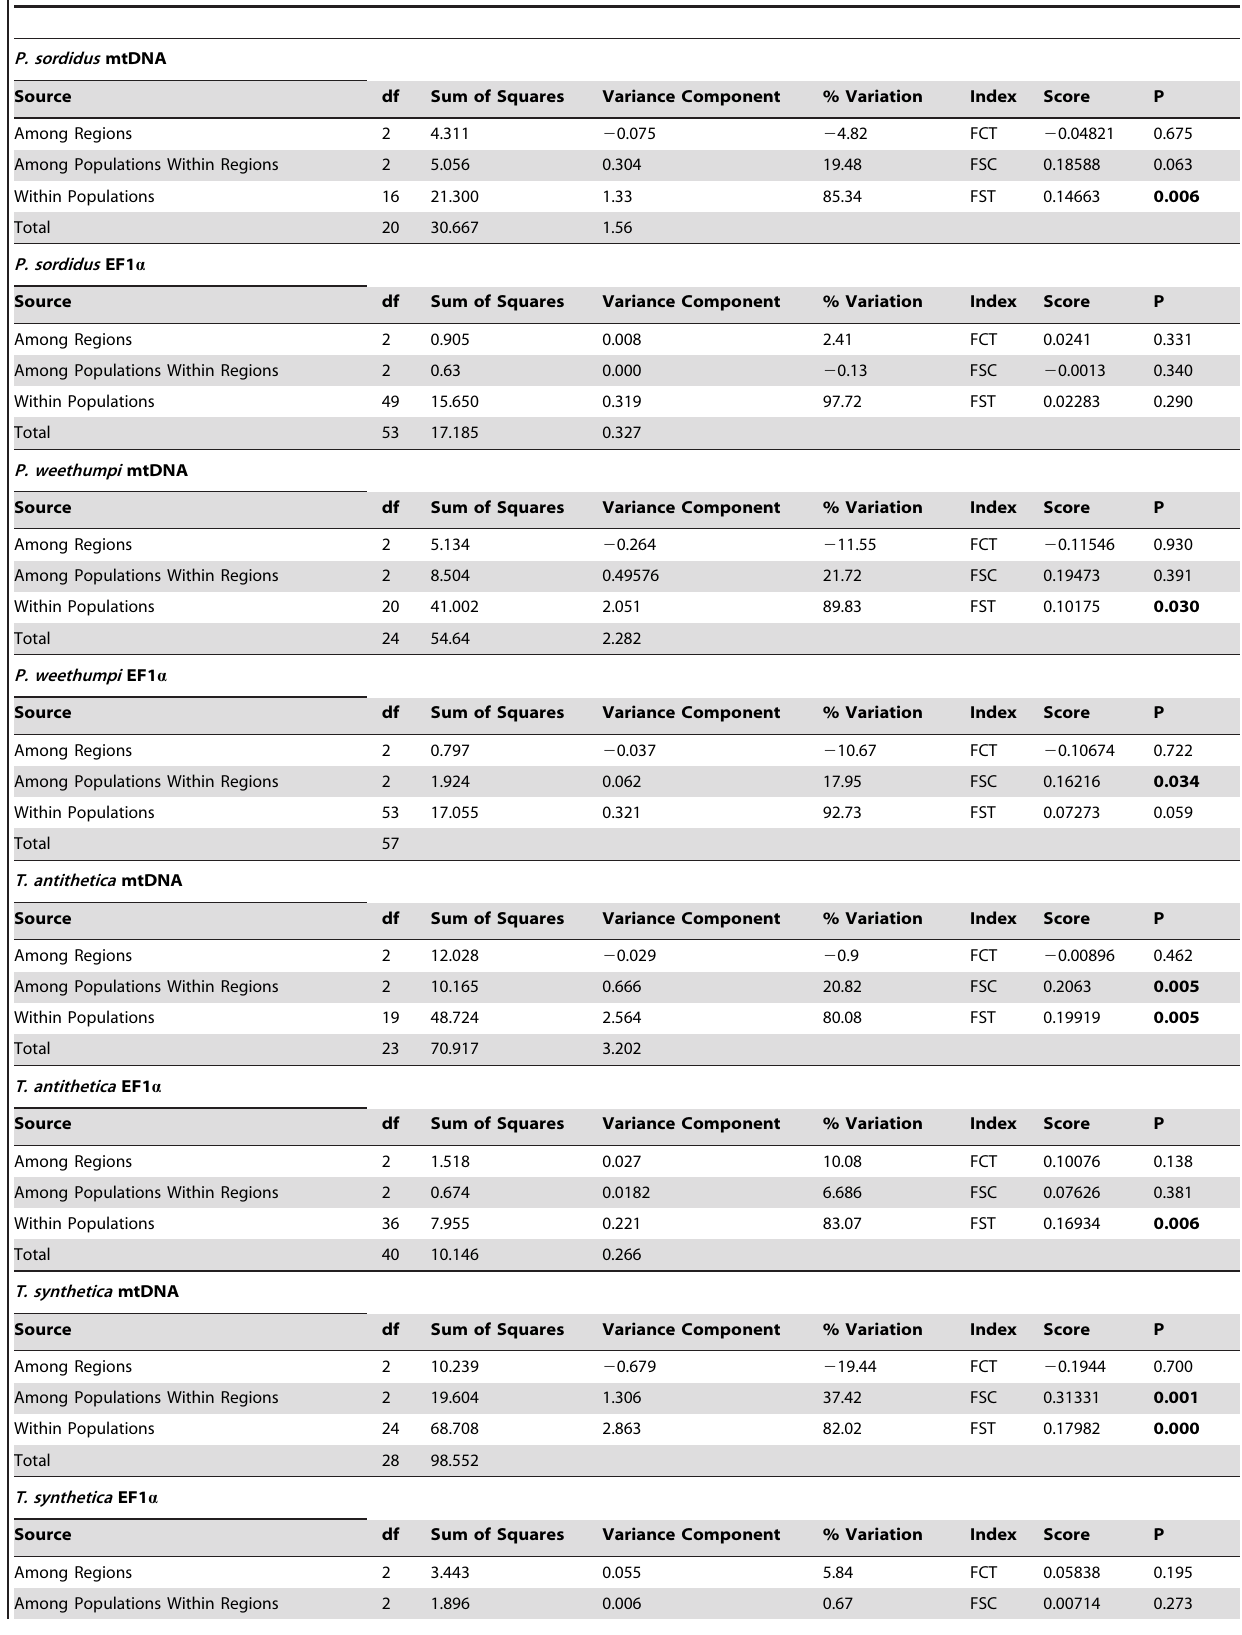
Table 3. Results AMOVAs calculated in Arlequin v. 3.5, by species and by locus.